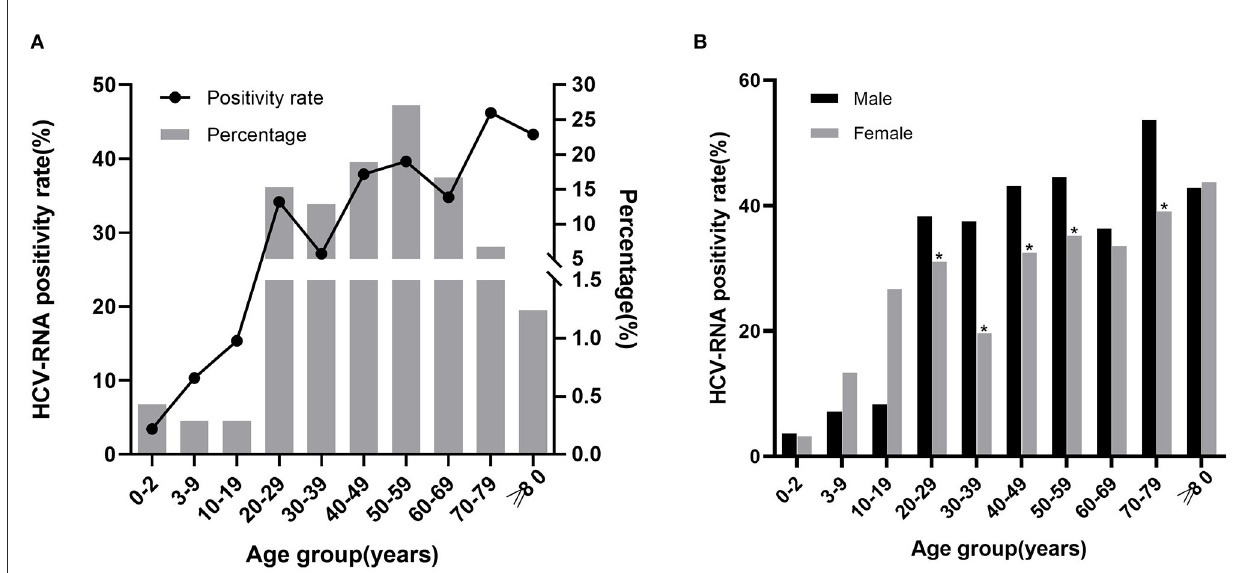
FIGURE3 The relationship between HCV RNA positivity rate with age and sex. (A) HCV RNA positivity rate in different age groups and age distribution of positive patients. The line chart represents the positivity rate, the histogram represents the percentage of positive patients. (B) HCV RNA positivity rate in males and females of different age groups. * P <